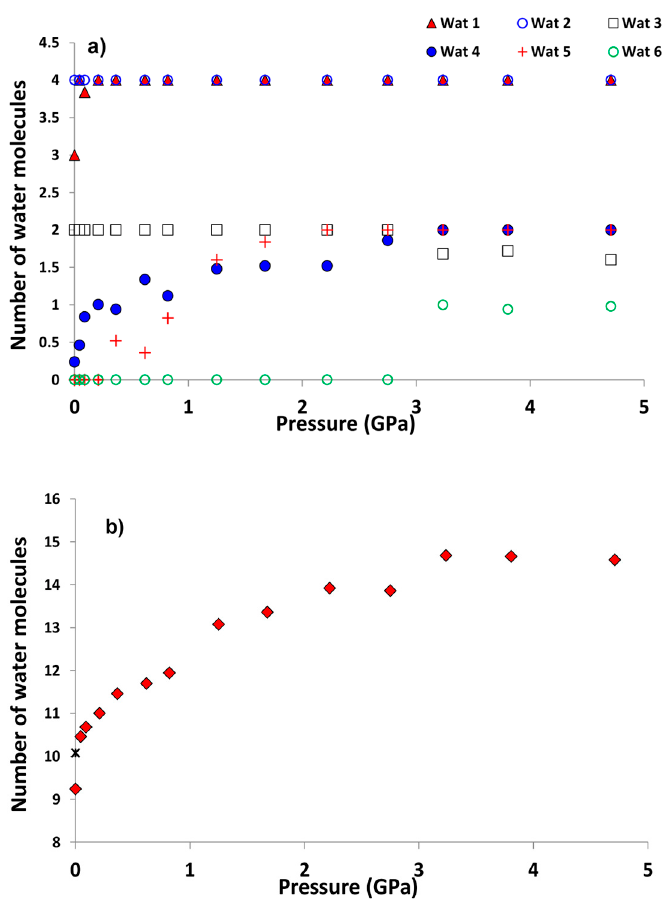
Figure 5. ( a ) Number of water molecules in the Wat1-Wat6 extraframework sites in amicite compressed in m.e.w. as a function of pressure; ( b ) total number of water molecules as a function of P. The cross indicates the number of water molecules after pressure release.